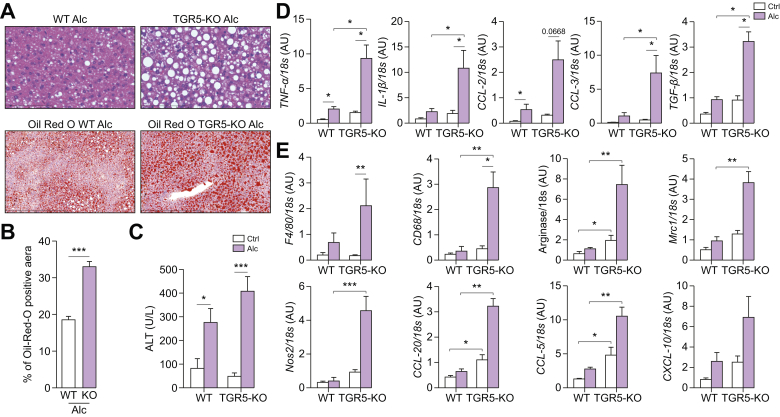
Liver injury in WT and TGR5-deficient mice after chronic alcohol consumption. Wild-type (WT) and Takeda-G-protein-receptor-5-deficient (TGR5-KO) mice were fed alcohol (Alc) or isocaloric maltodextrin (Ctrl). (A) Representative histological images of H&E and Oil Red O staining of the liver of alcohol-fed mice (scale bar: H&E = 100 μm and Oil Red O = 400 μm). (B) Quantification of Oil Red O staining. (C) Plasma ALT levels. (D–E) Liver mRNA levels of (D) pro-inflammatory cytokines and chemokines and (E) genes related to the macrophage phenotype. Kruskall-Wallis test and Dunn’s multiple comparison post-hoc test, ∗p <0.05, ∗∗p <0.01, ∗∗∗p <0.001. WT Ctrl n = 4, WT Alc n = 6, TGR5-KO Ctrl n = 4, TGR5-KO Alc n = 6. ALT, alanine aminotransferase.